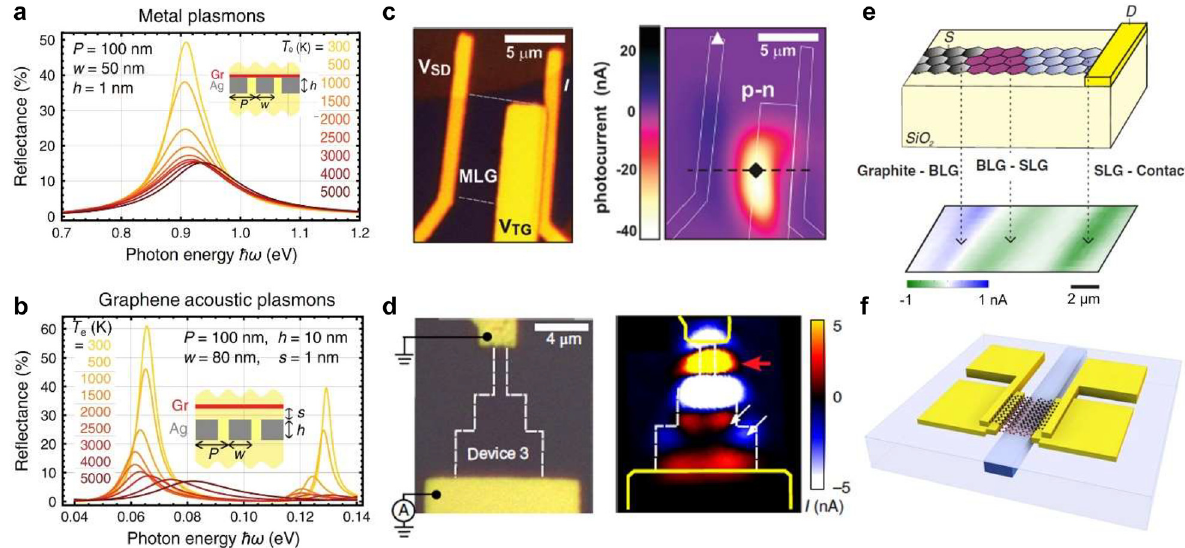
Figure 4: Photo-modulation processes of graphene: PTO and PTE. (a and b) PTO effect in graphene and graphene/metal hybrid systems. Variation in the reflection spectra of graphene/Ag system in the (a) NIR and (b) far/mid-IR plasmonic regions for different electronic temperatures, T e , in graphene, where P , w , h are geometrical parameters and s is the spacings. All dielectrics in the structure (yellow regions in the insets) are taken to have a permittivity ε = 2. (c – f) PTE effect in graphene- baseddevices.Panel(a)and(b)adaptedfrom[54].(c) Dual-gated deviceincorporatingboronnitridetop-gatedielectricandspatiallyresolved photocurrent map at T = 40 K with laser wavelength 850 nm. Adapted with permission from [60]. (d) Device with three rectangular graphene regions with increasing widths; the white arrows in the photocurrent map (right panel) indicate that the photocurrent is generated from the grapheneedge,the red arrowsdenotesthe photocurrent along thestraight edges ’ regionsof single layergraphene.Adapted with permission from[61].(e)Devicelayoutandphotocurrentmapinthetransparentsubstratedevice,witha fl akethatcontainsadjacentregionsofsingle-and bi-layer graphene, as well as graphene – metal contact. Adapted with permission from [62]. (f) Waveguide integrated PTE graphene photo- detector with a split-gate geometry where PTE current is generated by absorbingthe waveguiding modes. Adapted with permissionfrom